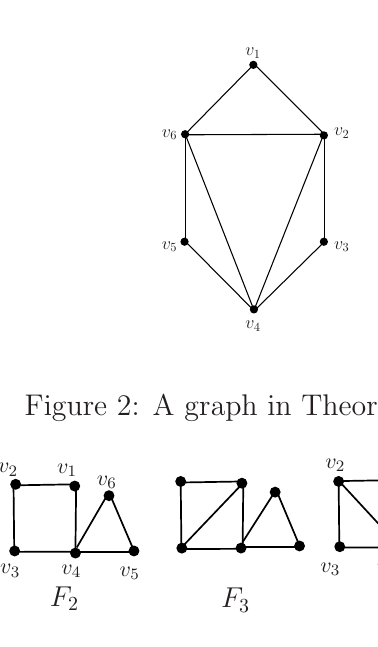
Figure 3: Graphs in Theorem